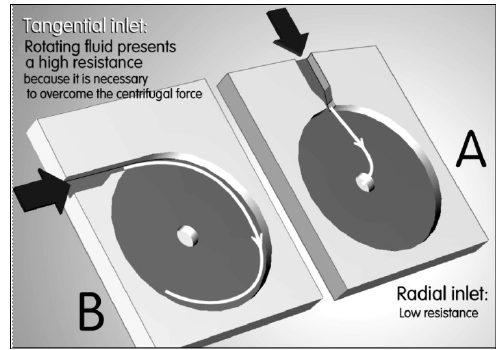
Fig. 5. Another control effect used in fluidics is the difference in resistances between radial non-rotating flow A and the high-resistance tangential regime B in which the flow has to overcome the centrifugal acceleration.